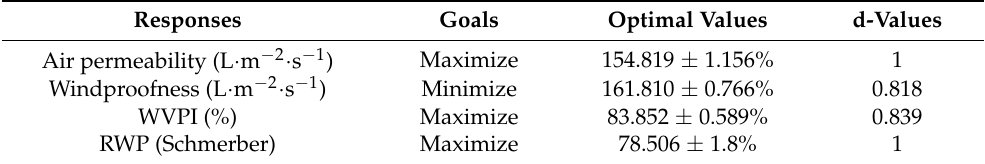
Table 9. Optimized responses of the used coating process (D-value = 0.771). Responses Goals Optimal Values